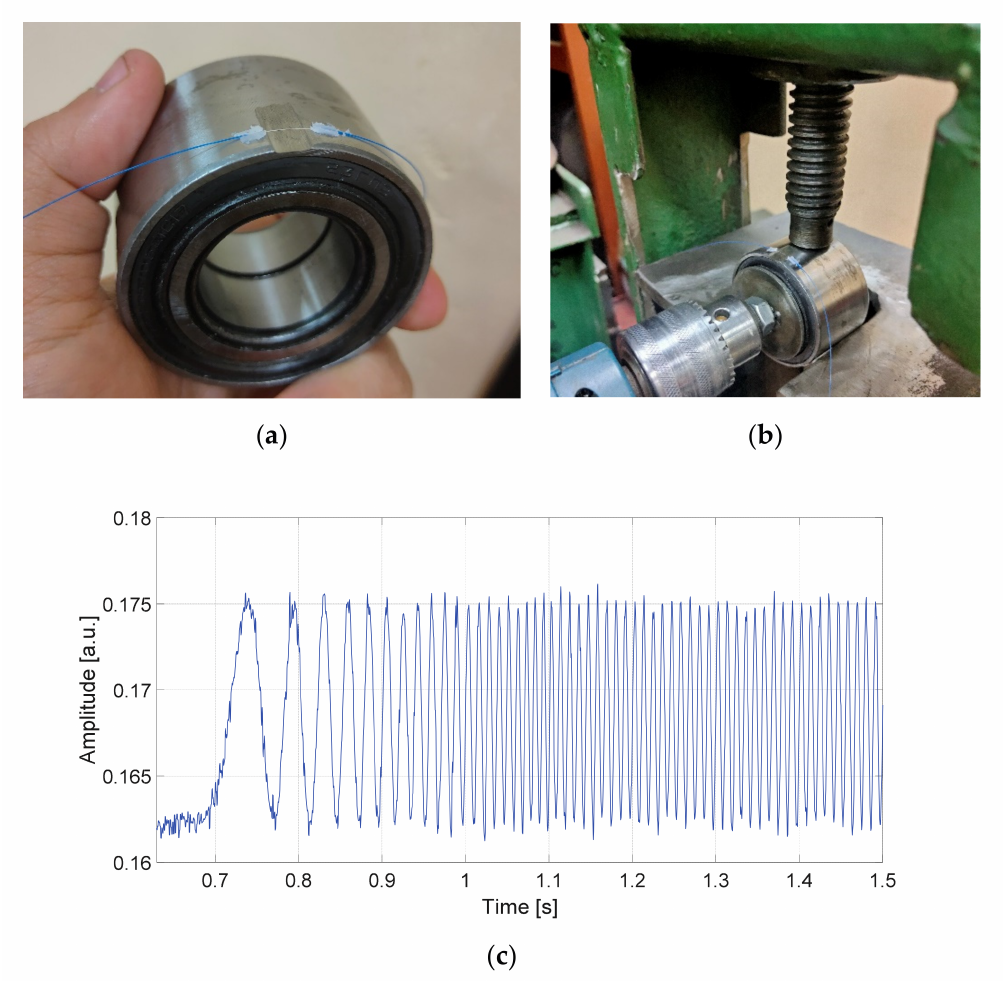
Figure 11. Static load test: ( a ) prototype load-sensing bearing with AFBS sensor; ( b ) experimental setup with a mechanical press for static load test; ( c ) relative amplitude of the resulting beating signal at the photodetector during the static load